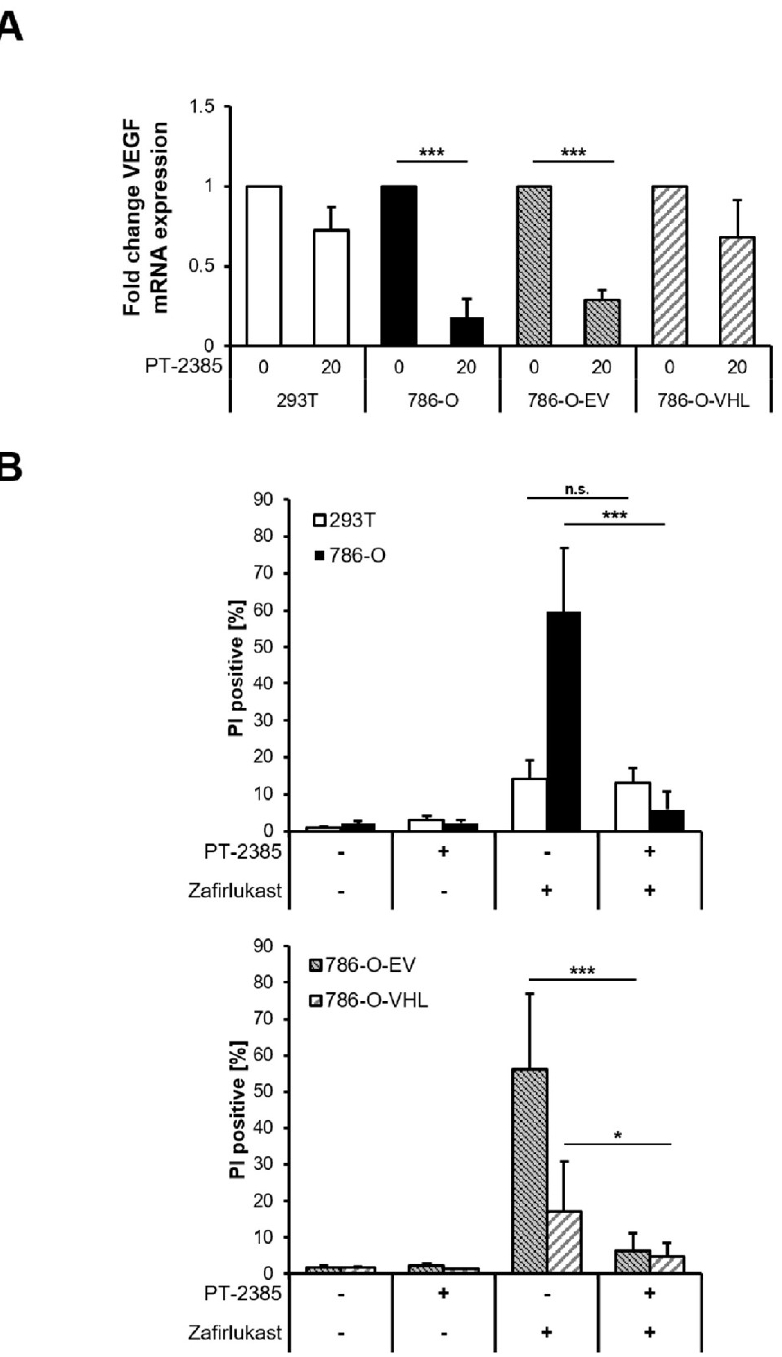
Figure 5. Inhibition of HIF-2 α rescues zafirlukast-induced cell death. ( A ) mRNA expression levels of VEGF of the indicated cell lines treated with the HIF-2 α inhibitor PT-2385 (20 µ M) for 24 h were determined using qRT-PCR. Data are normalized to GAPDH expression and are presented as x-fold mRNA expression compared to control. Mean and SD of four independent experiments performed in triplicate are shown. *** p < 0.001; ( B ) 786-O and 293T (upper) and 786-O-EV and 786-O-VHL (lower) cells were pre-treated with the HIF-2 α inhibitor PT-2385 (20 µ M) for 24 h, followed by treatment with DMSO or 100 µ M zafirlukast for 24 h, after which cell death was determined by quantifying PI uptake. Data are presented as percentage of PI-positive cells and mean and SD of three independent experiments performed in triplicate are shown. * p < 0.05, *** p < 0.001, n.s.: non-signif- icant.